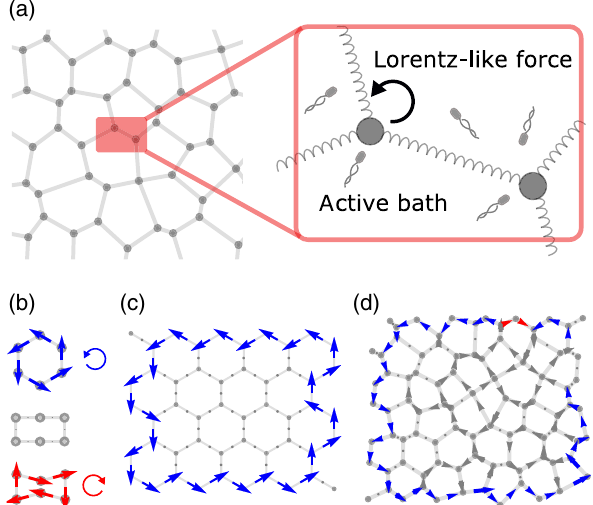
FIG. 1. The model and the energy flux in example networks. (a) Schematic of the model, a spring-mass network subject to a Lorentz-like force and immersed in an active bath. (b) – (d) Averaged energy flux from numerical calculations for example networks. The flux direction and pattern can be controlled by the network geometry. In these figures, gray lines and dots represent the mechanical equilibrium structure of the network, and the arrows represent the flux between particles, whose length is proportional to the flux magnitude. An arrow is colored blue if it is counterclockwise (CCW), red if clockwise (CW), and gray for fluxes not on the boundary. The numerical calculations were performed with all parameters set to